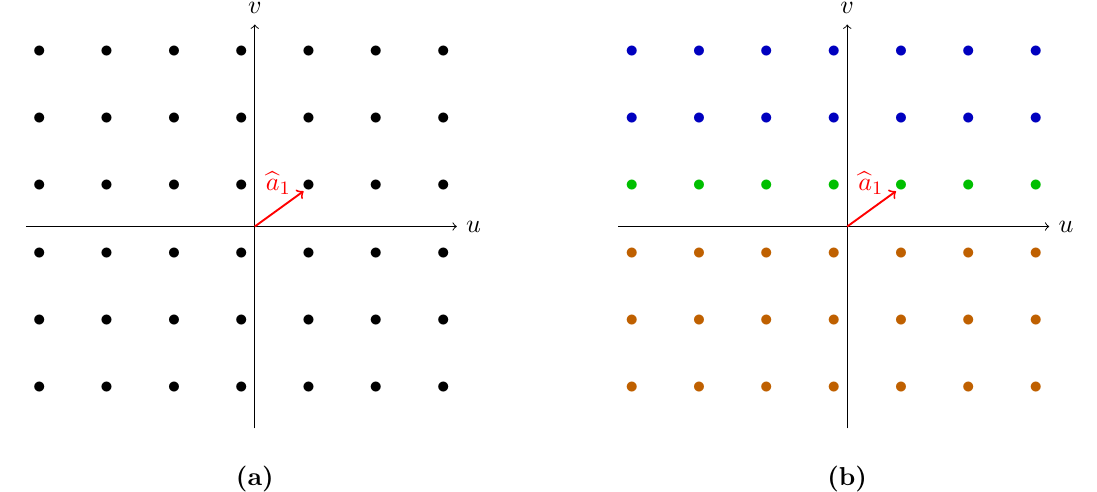
a 1 as in (4.27). (b) Split of the b